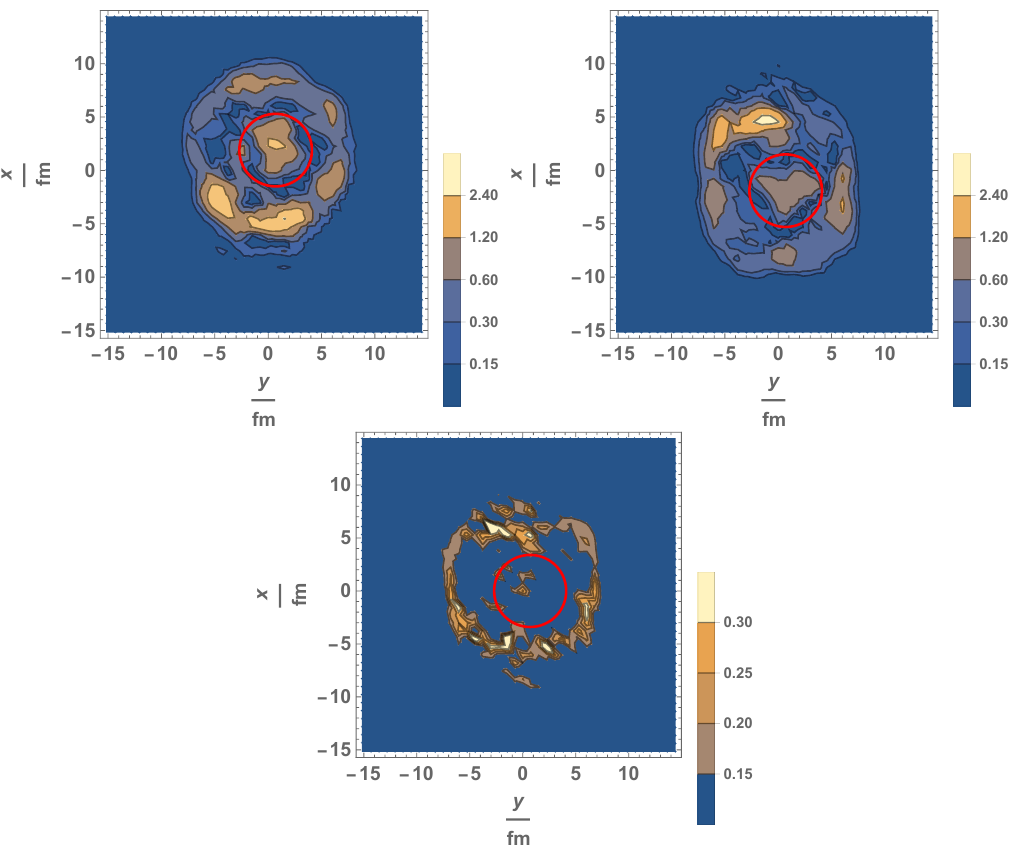
Figure 6 . The residual ∆ at proper time τ = 0 . 106 fm /c . For rapidity ξ = − 0 . 5 (left) and ξ = 0 . 5 (right) in the first row and vanishing rapidity for the plot in the second row. We display the region R described in (4.5) by a red circle in the plots